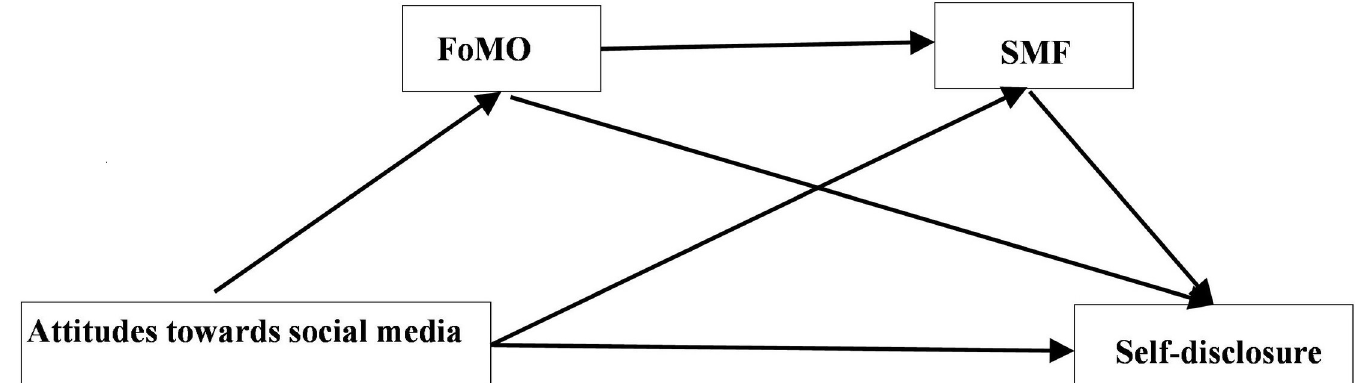
Fig 1. Relationships of attitudes towards social media, FoMO, SMF and